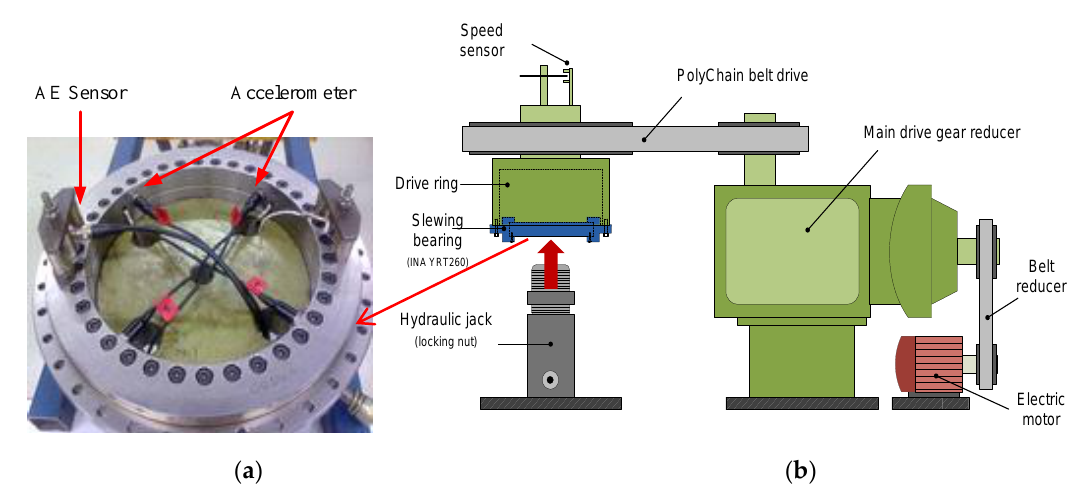
Figure 7. ( a ) Sensor attachment; ( b ) Schematic of laboratory slew bearing test rig.